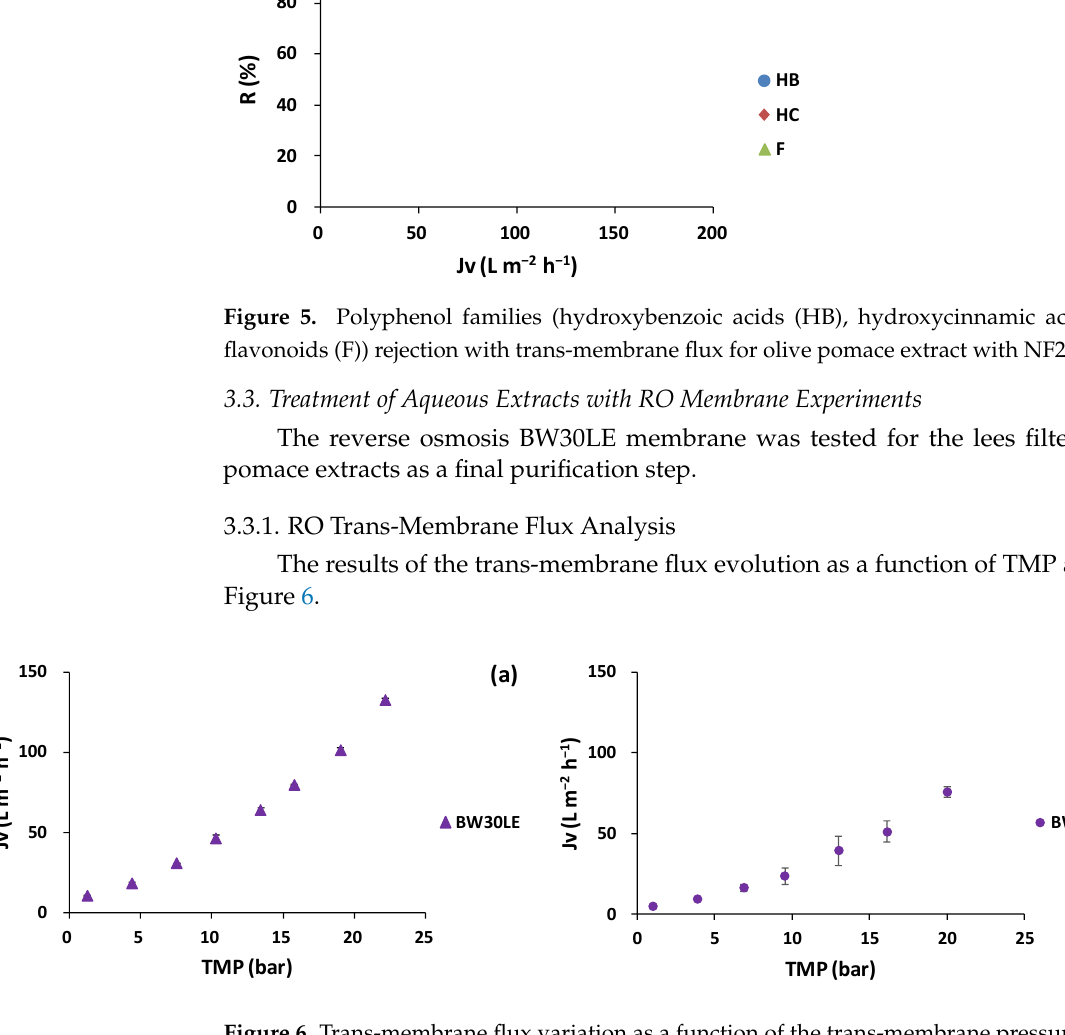
10 of 15 Figure 4. Polyphenol families’ rejection of hydroxybenzoic acids (HB), hydroxycinnamic acids (HC), and flavonoids (F) with trans-membrane flux for lees filters extracts with ( a ) NF90 and ( b ) Duracid